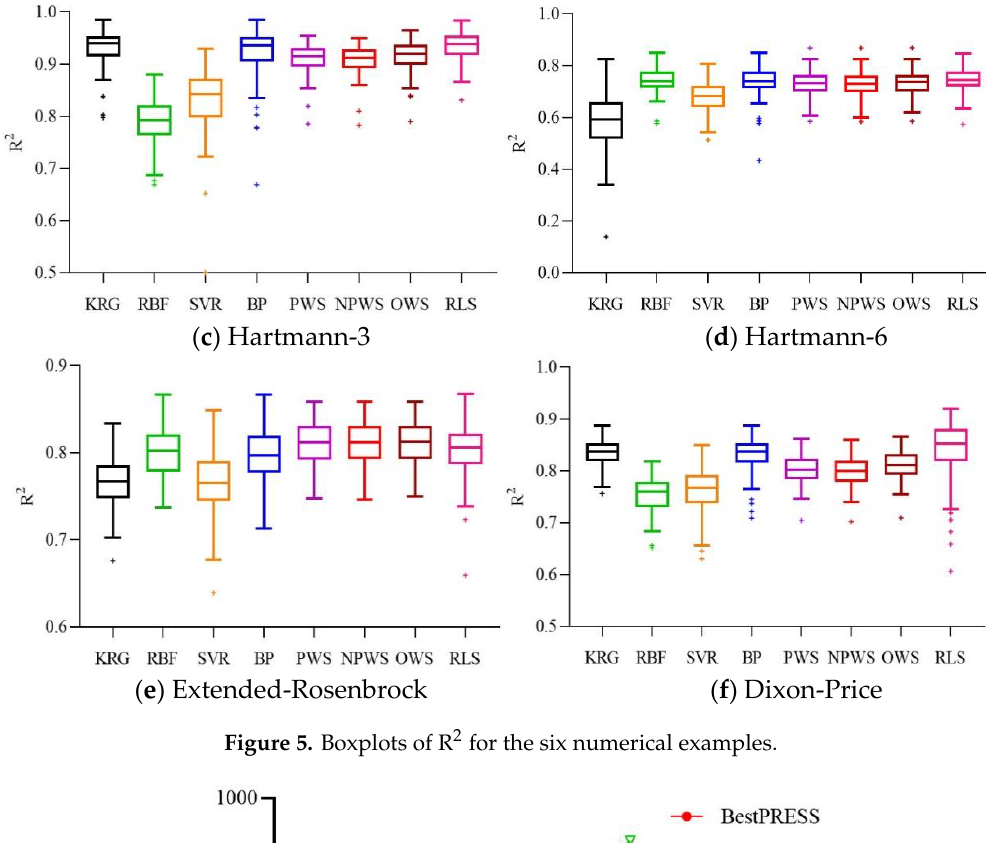
Figure 5. Boxplots of R 2 for the six numerical examples.